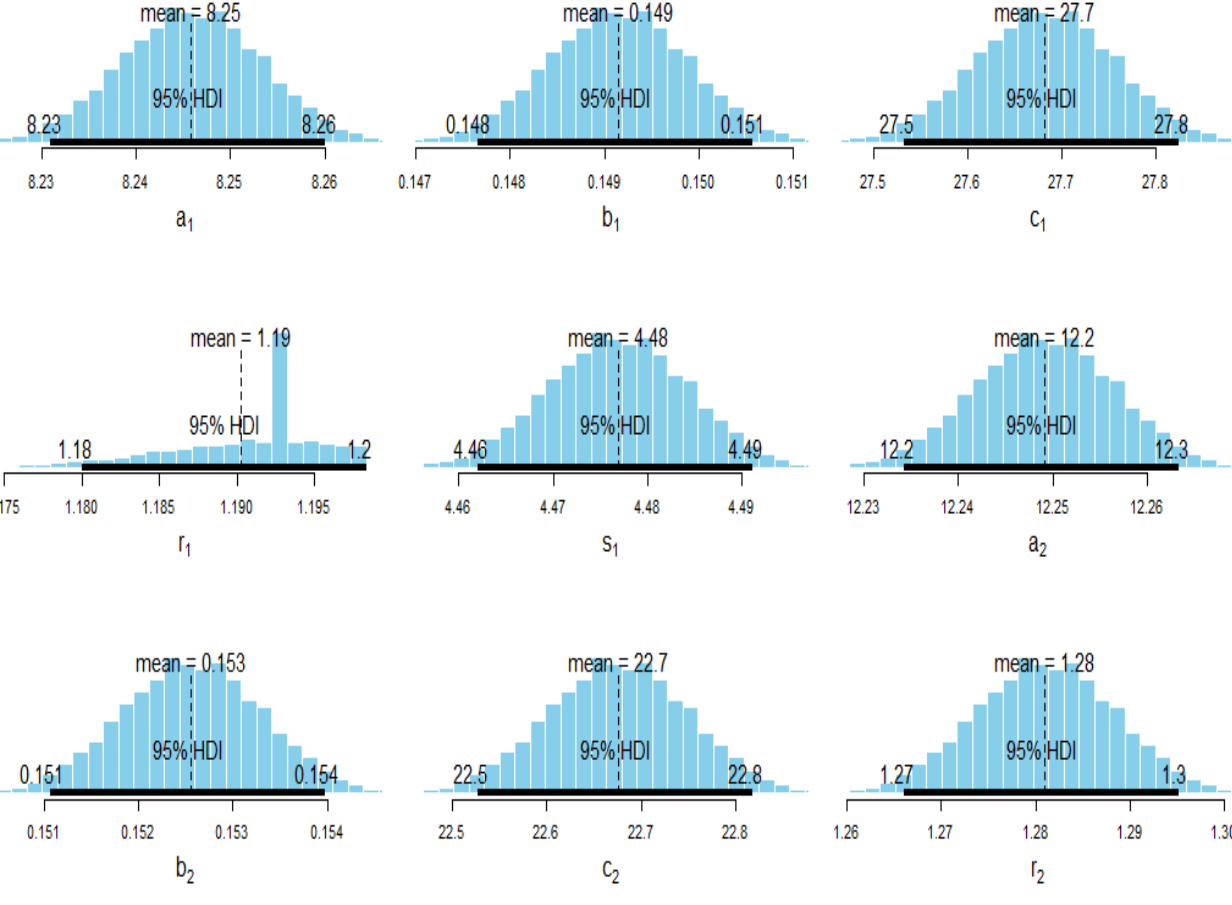
Figure 7. MCMC density and HDI intervals for the Bayesian estimation of model for complete Blad- der data for the last two parameters. In addition, Bayesian credible interval estimates of the parameters are obtained nu- merically using Markov chain Monte Carlo (MCMC) techniques. That is, samples are sim- ulated from the joint posterior distribution in Equation (12) using the Metropolis–Hasting algorithm to obtain the posterior mean values of the estimates of the parameters by MCMC. Table 10 reports the estimates of the MEKW parameters with the corresponding SE and credible confidence intervals using the HDI algorithm of the Bayesian estimators.